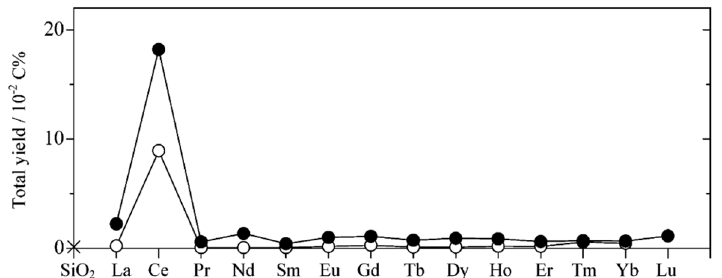
Figure 46. Total yield of hydrocarbons using 0.1 and 0.2% of various metals loaded on SiO 2 . Reprinted with permission from [62]. Copyright (2008), American Chemical Society.